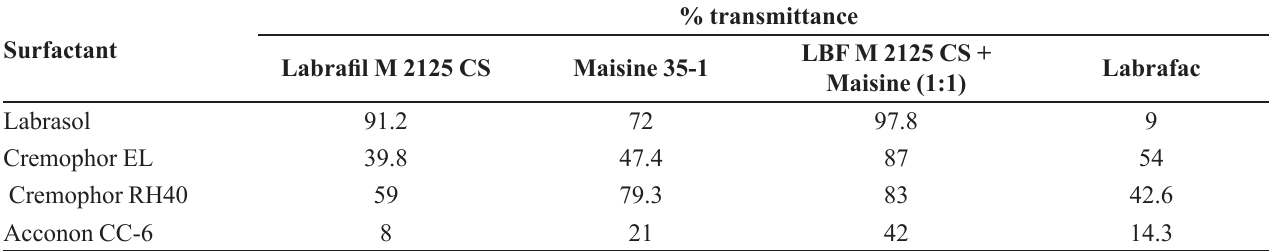
of Labrafil M 2125 CS and Maisine 35-1 (1:1) ratio. TABLE I – Emulsification efficiency of various surfactants using different oily phases